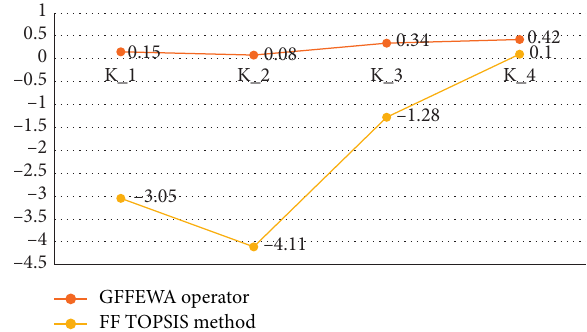
Figure 1: Comparison of the GFFEWA operator and FF TOPSIS method.